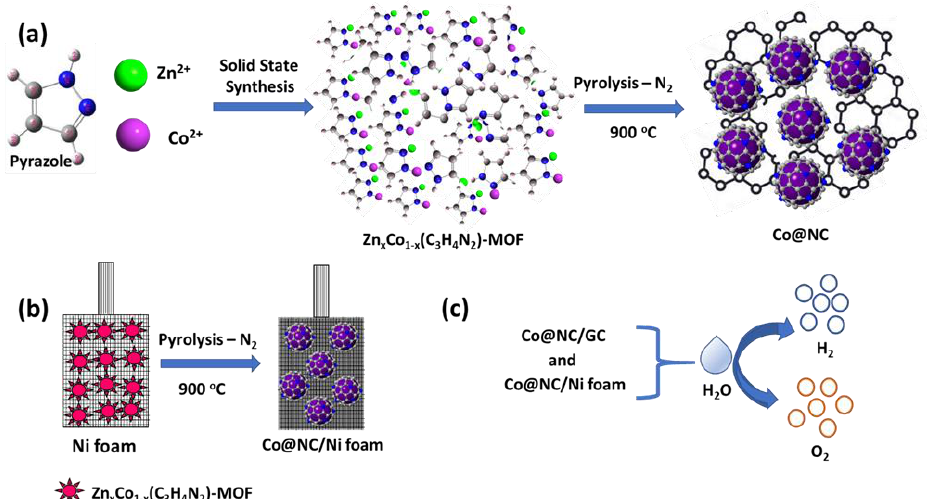
Figure 1. ( a ) Schematic representation of the synthesis of Co@NC catalyst by a mechanochemical synthesis process ( b ) synthesis of Co@NC catalyst on Ni foam ( c ) application of Co@NC catalyst for water